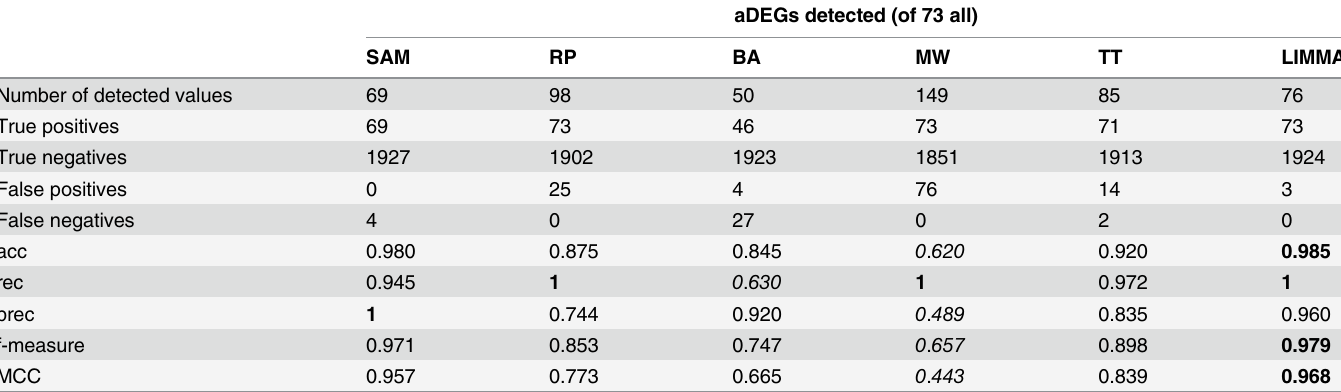
Table 7. Number of aDEGs detected and assessment parameters by each method in Dataset2 (in bold — the best, in italics — the worst).